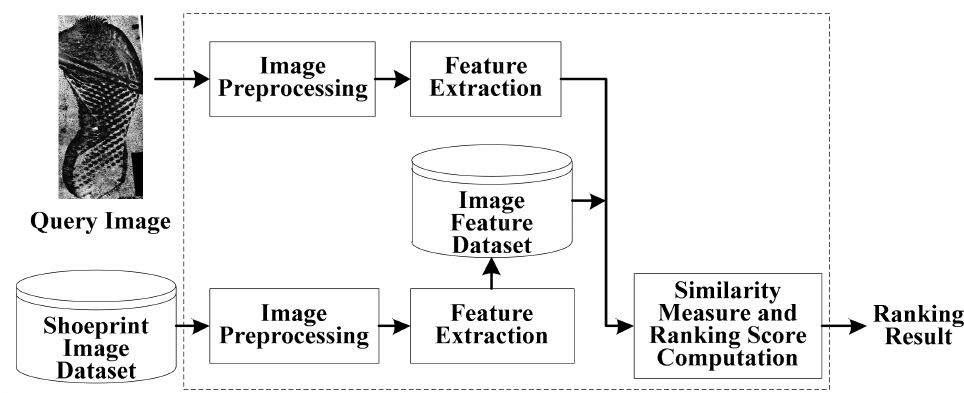
Figure 2. The framework of the automatic shoeprint retrieval